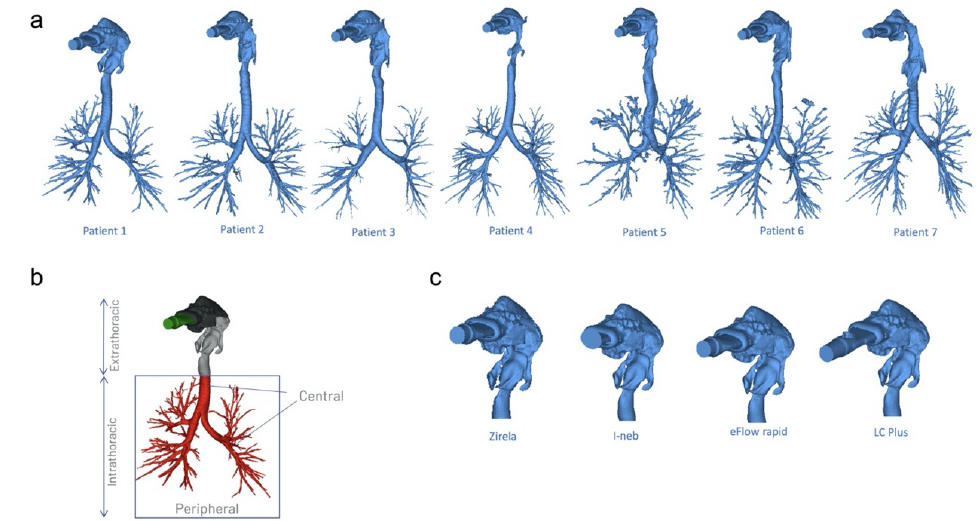
Figure 5. ( a ) Three-dimensional (3D) reconstructions of the airway tree from high resolution com- puted tomography (CT) scans obtained from seven patients with mild cystic fibrosis. ( b ) Deposition areas are divided into extrathoracic regions, comprising the mouth and upper airways, and the in- trathoracic airways. The intrathoracic region is further divided into central airways, from the start of the trachea and including all the airways visible on the CT scans, and the peripheral lung regions.